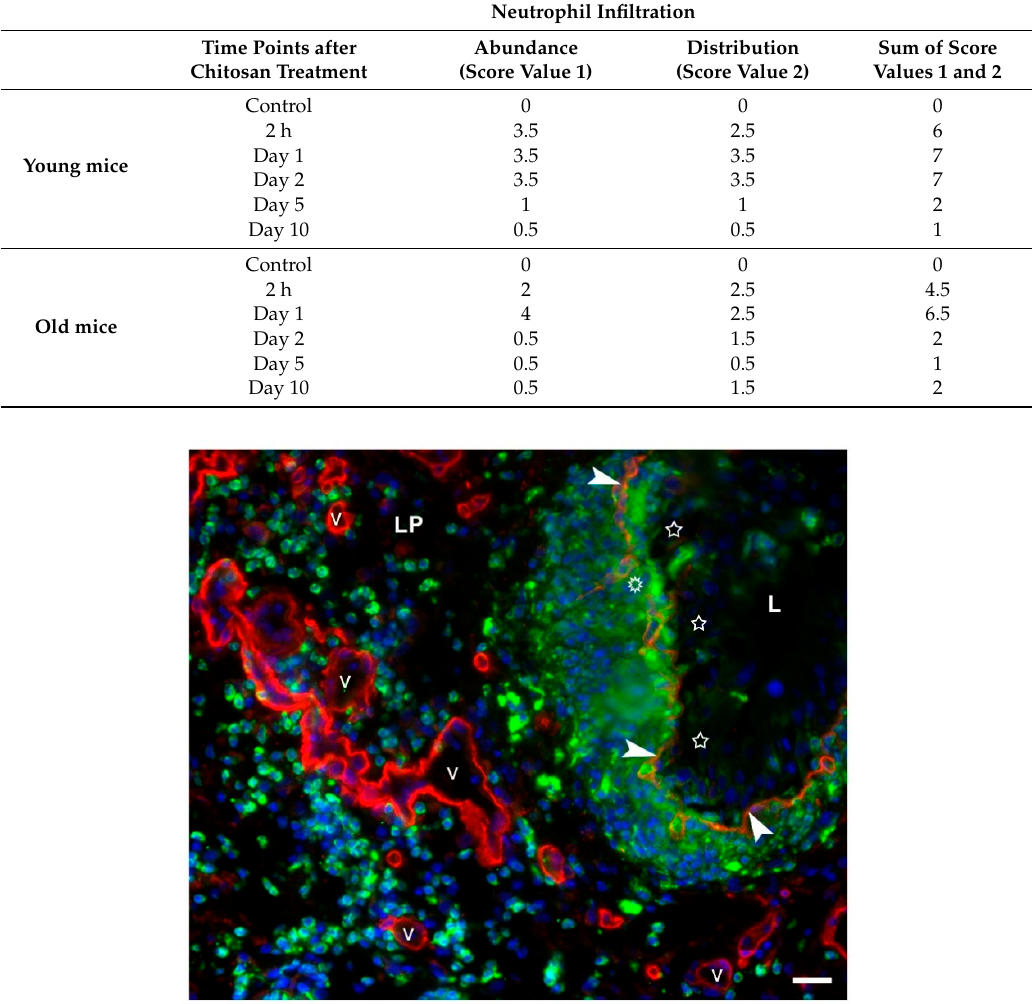
Figure 10. Representative micrograph of immunofluorescent detection of neutrophils in the urinary bladder wall of young mice on day 2 after chitosan treatment. Numerous extravascular and tissue-invading neutrophils (green fluorescence) are present in the lamina propria (LP) and even in the lumen (L) of the bladder. Collagen IV (red fluorescence) is immunolabeled to mark the basal lamina under the urothelium (arrowheads) and endothelium of blood vessels (v). Note that the basal lamina (asterisk frame) under the urothelium and the urothelium (star frames) are damaged at some places. Cell nuclei are stained with 4 (cid:48) 6-diamidino-2-phenylindole (DAPI) (blue fluorescence). Scale bar: 20 µ